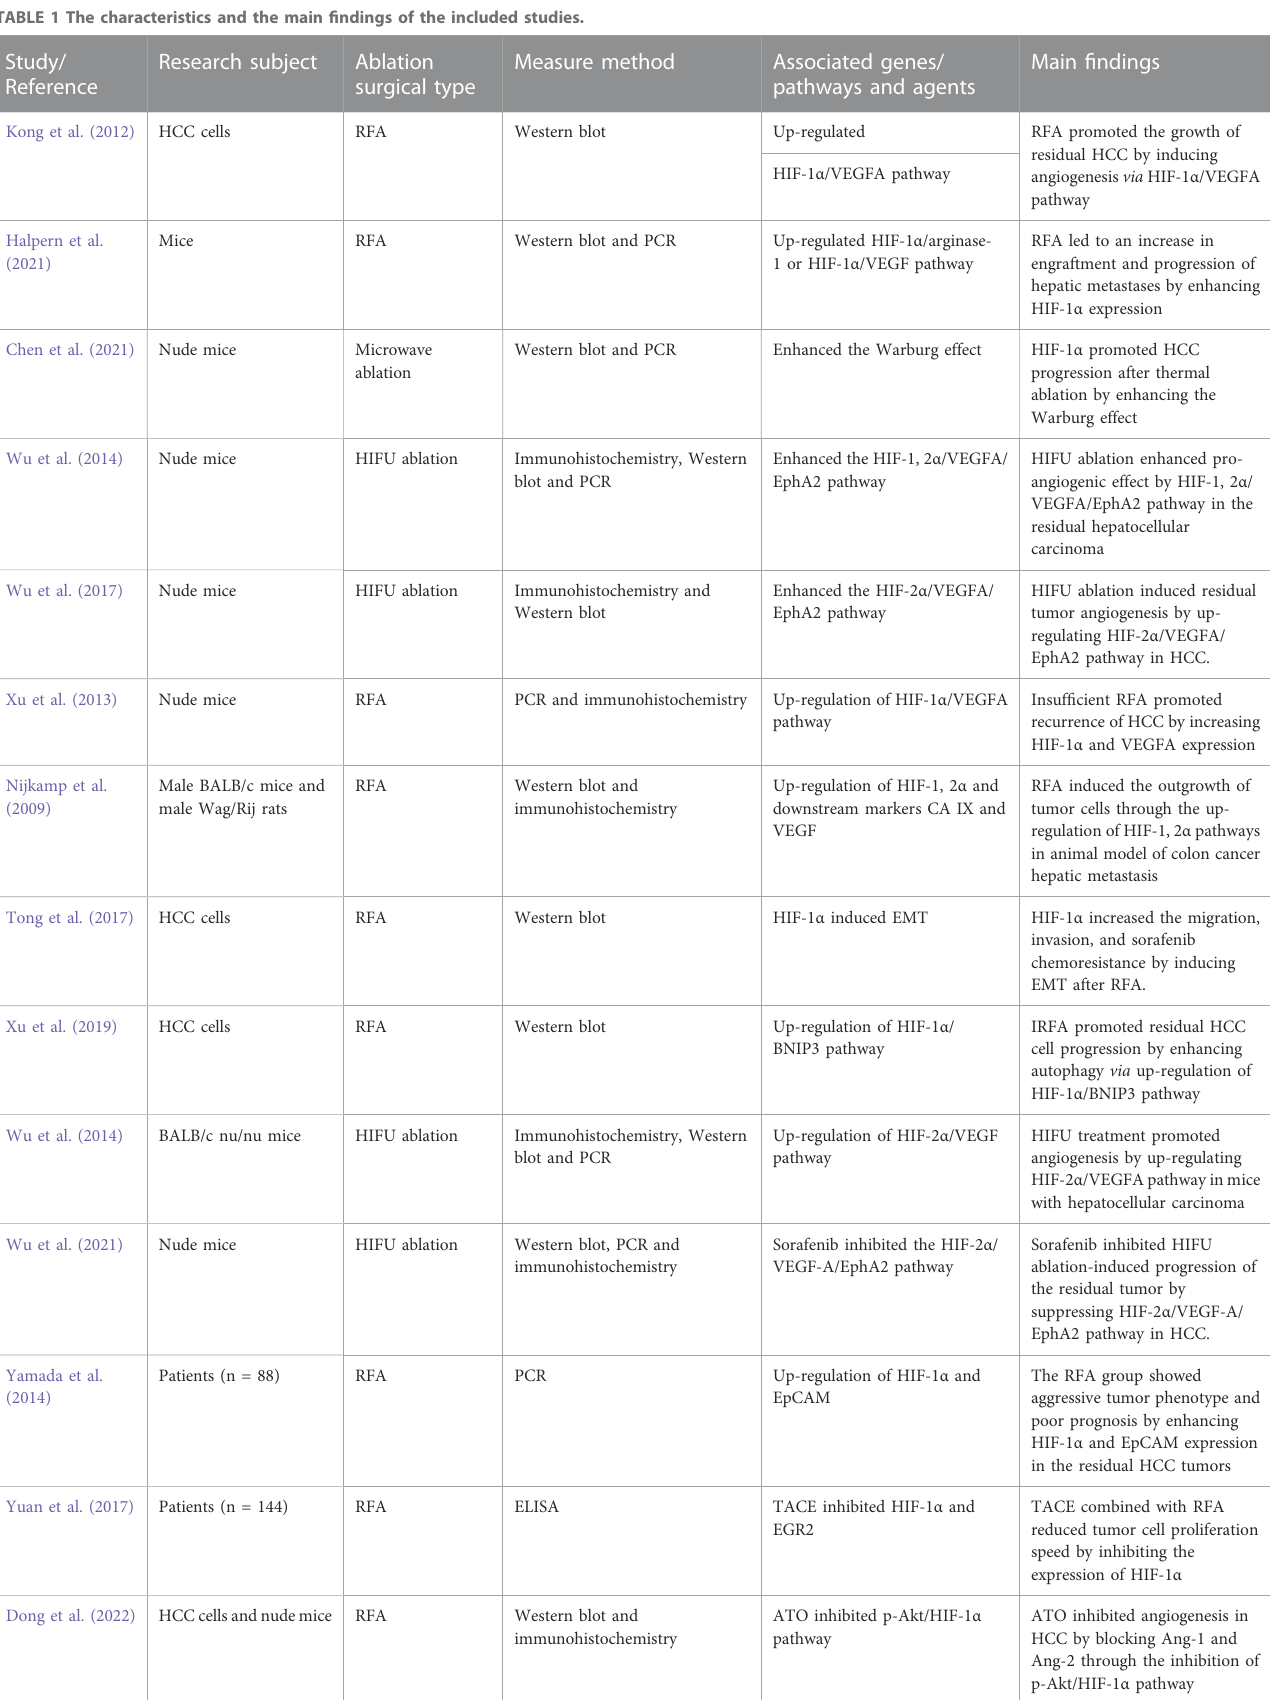
TABLE 1 The characteristics and the main fi ndings of the included